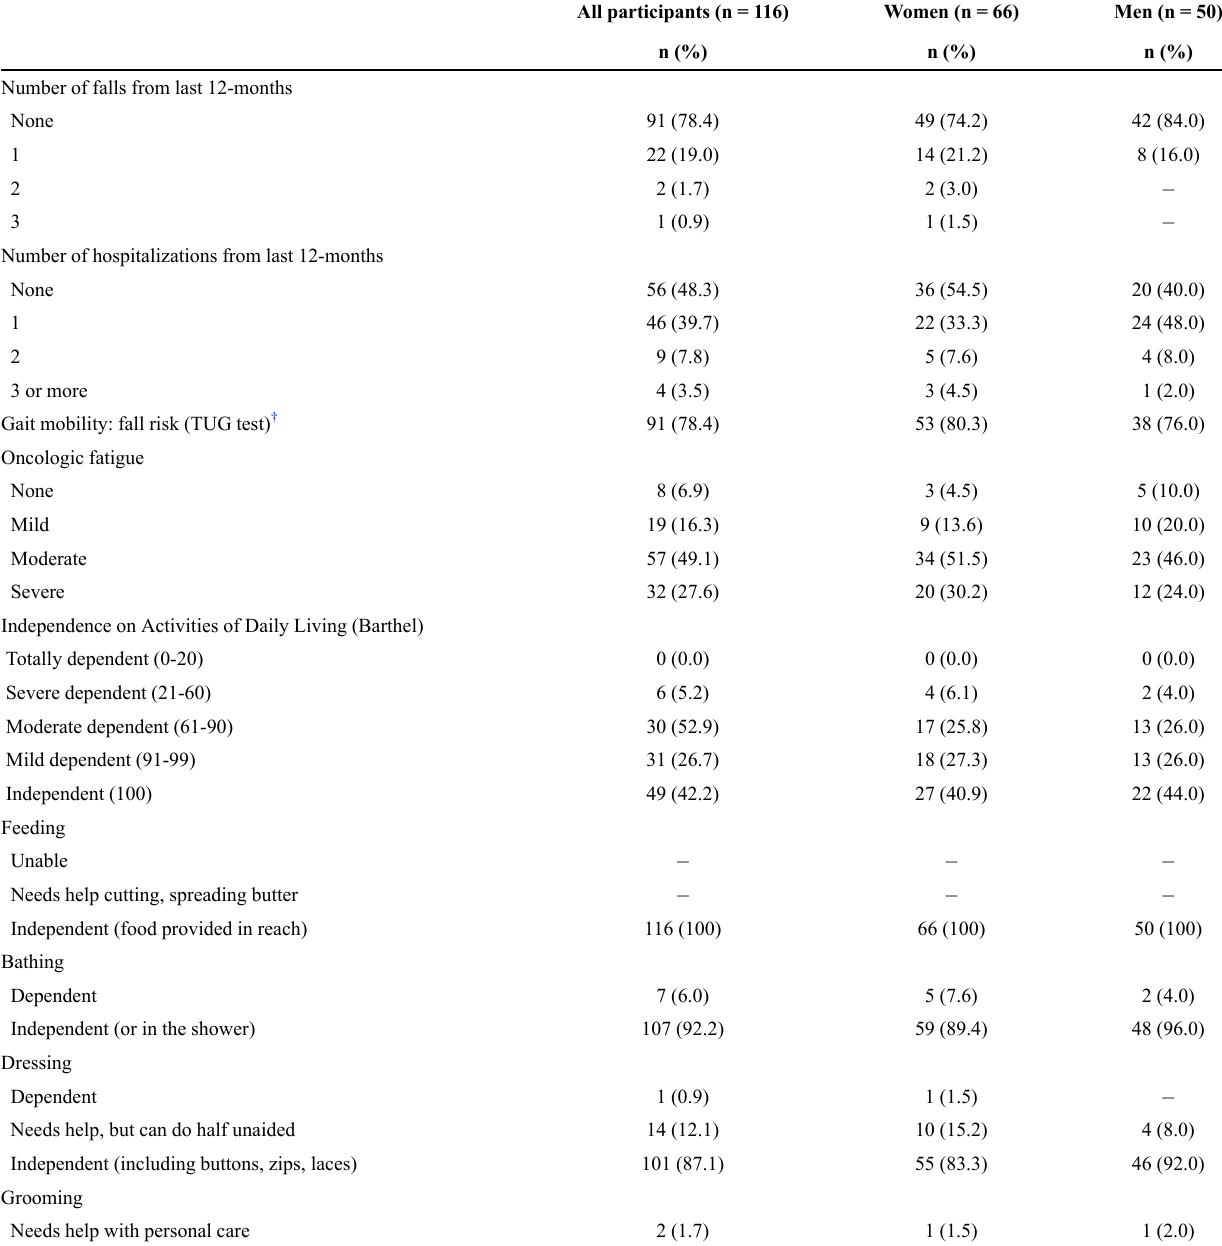
Table 3 - Characteristics of the functional status of older adults with